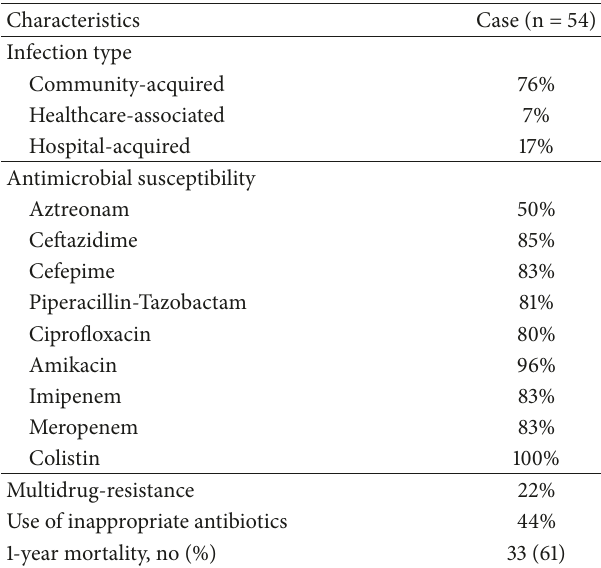
Table 2: Additional characteristics of patients with Pseudomonas bacteremia in the ED including antimicrobial susceptibility profile of the